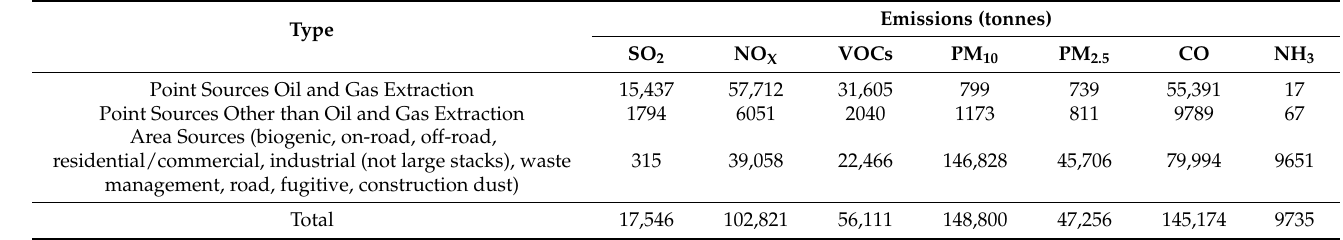
Table 2. 2013 Annual point and area emission sources of primary pollutants in the modelling